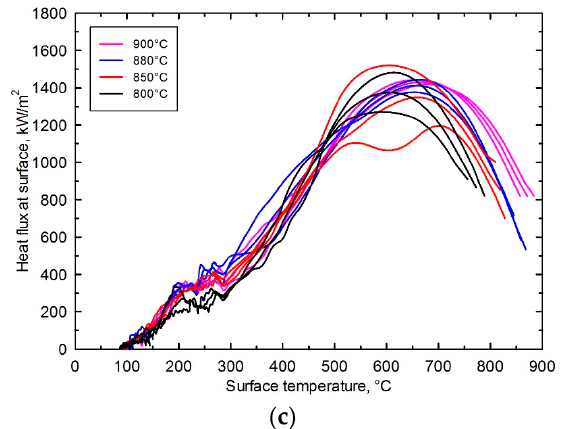
Figure 8. Boiling curves obtained from laboratory data, effect of: ( a ) impact jet velocity, ( b ) oil temperature and ( c ) initial steel temperature.